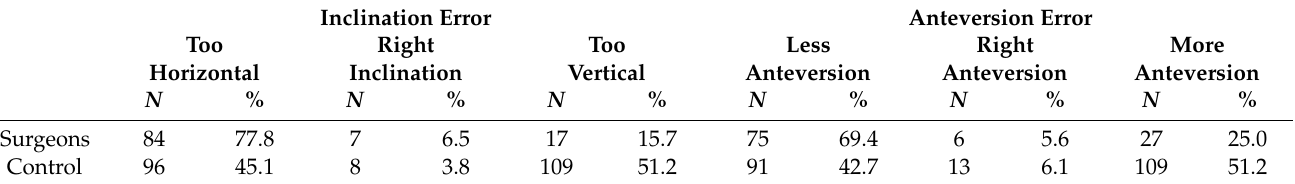
Table 5. Mean errors according to position and